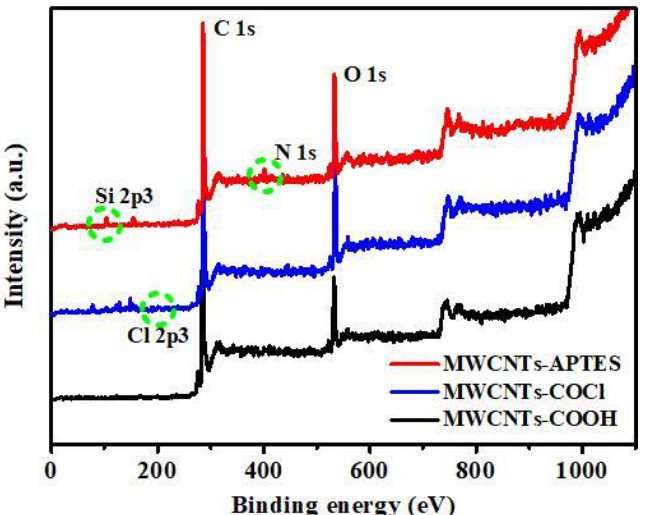
Figure 4. Wide-scan survey XPS spectra of MWCNTs, MWCNTs-COOH, MWCNTs-COCl and MWCNTs-APTES.